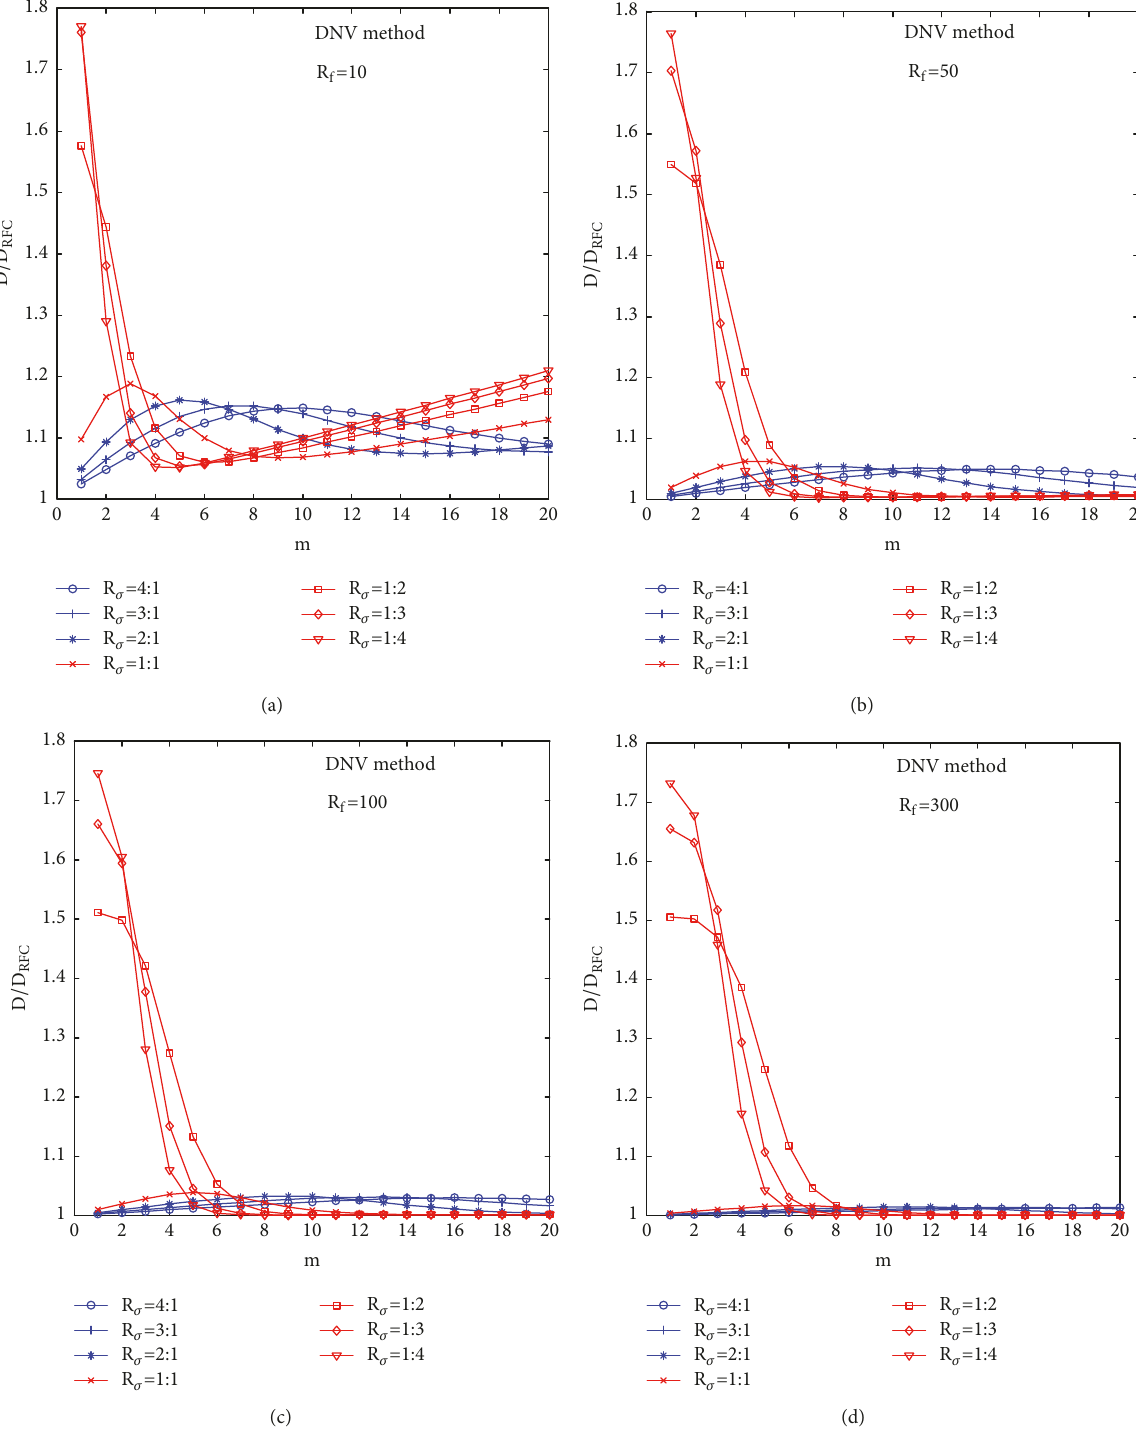
they have the same peak and trough is fulfilled. The combined loading process can be seen as in Figure 10. Different combinations have quite distinct time-domain characteristics, as seen in Figure